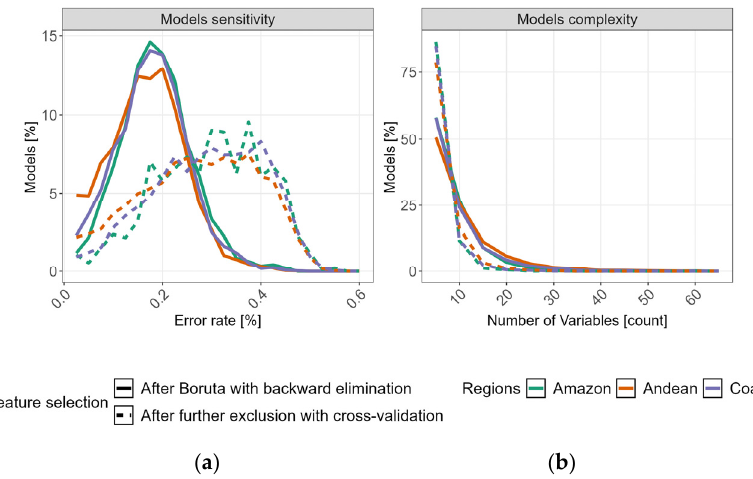
Figure 5. Frequency lines for ( a ) model sensitivity and ( b ) model complexity aggregated by region after analysis using the Boruta algorithm with backward elimination and further exclusion with cross-validation.